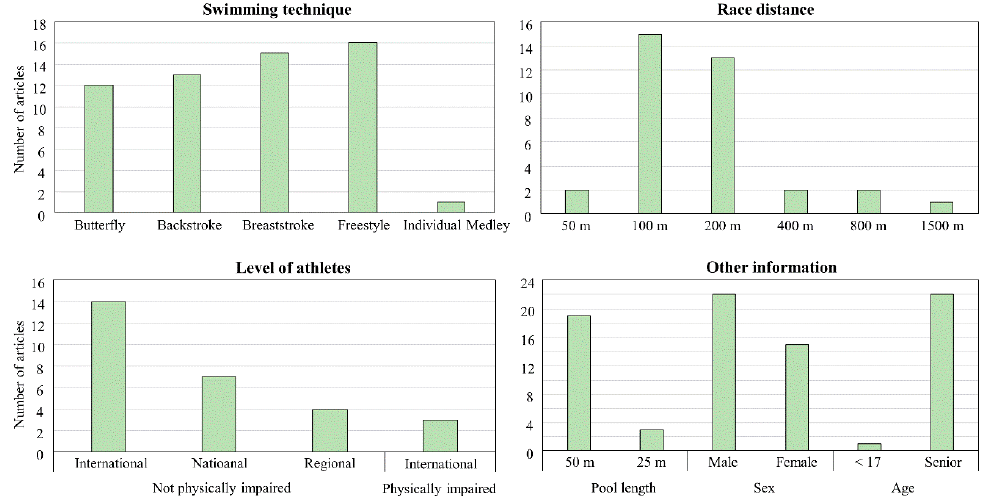
Figure 2. Summary of the key information extracted from the reviewed articles. Despite the common practice of dividing a race into the start, clean swimming, turn,